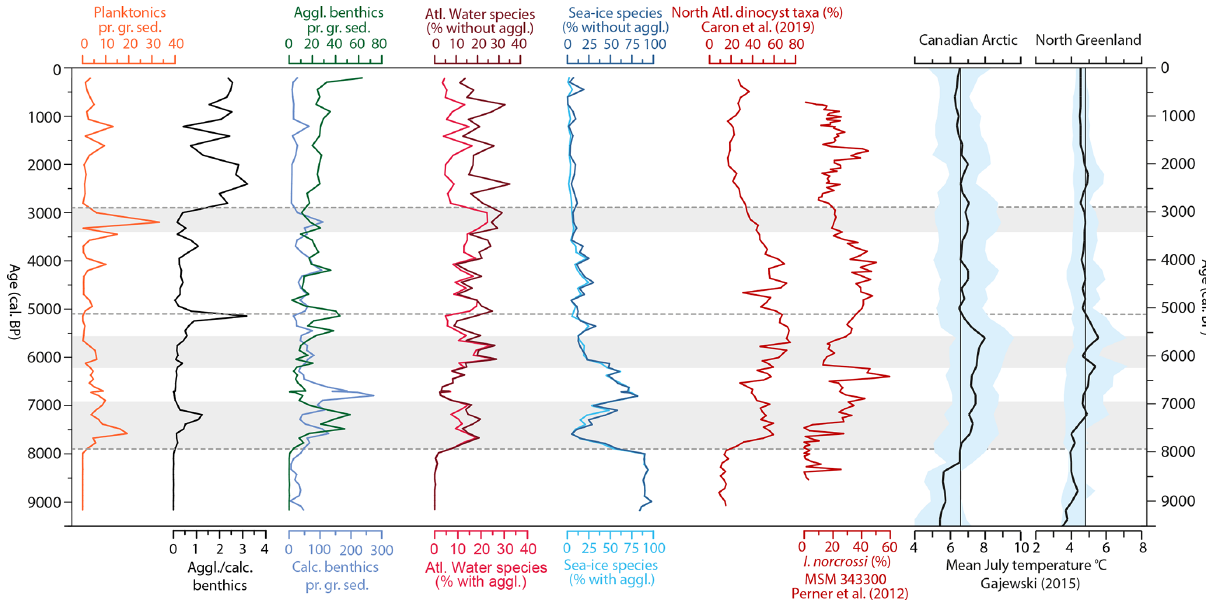
Figure 7. The green and purple curves show the comparison of the agglutinated benthics and calcareous benthics in individuals per gram of wet sediment, respectively. The sea-ice indicator species curves represent a grouping of the two sea-ice indicator species, S. feylingi and B. pseudopunctata , shown in percentages, including with agglutinated species (light blue) and without agglutinated species (dark blue). C. neoteretis , C. reniforme , and I. norcrossi make up the Atlantic Water indicator species shown in percentages, including with agglutinated species (light red) and without agglutinated species (dark red). The grey bars represent periods of strengthening of the WGC related to a stronger Atlantic Water entrainment. The foraminiferal data are compared to North Atlantic dinocyst taxa (Caron et al., 2019) and the Atlantic Water indicator species I. norcrossi from core MSM343300 from Disko Bugt (Perner et al., 2012). Additionally, two temperature reconstruction records are included, which show the mean regional July temperature (black line) from selected sites and were constructed by using the modern analogue technique (MAT) on pollen records from lake sediments (Gajewski, 2015). The light-blue shaded areas indicate the regional 1 standard deviation, and the straight vertical line is the long-term average of the